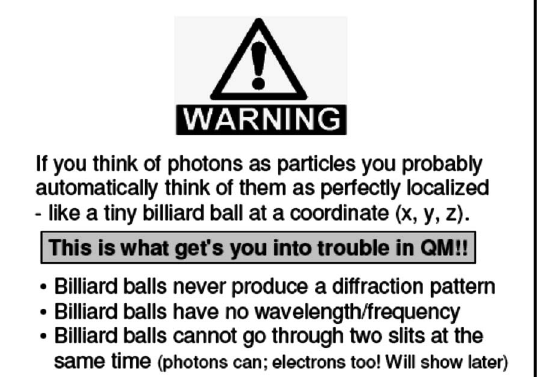
FIG. 3. A lecture slide as used in PHYS3A during the discussion of photons.